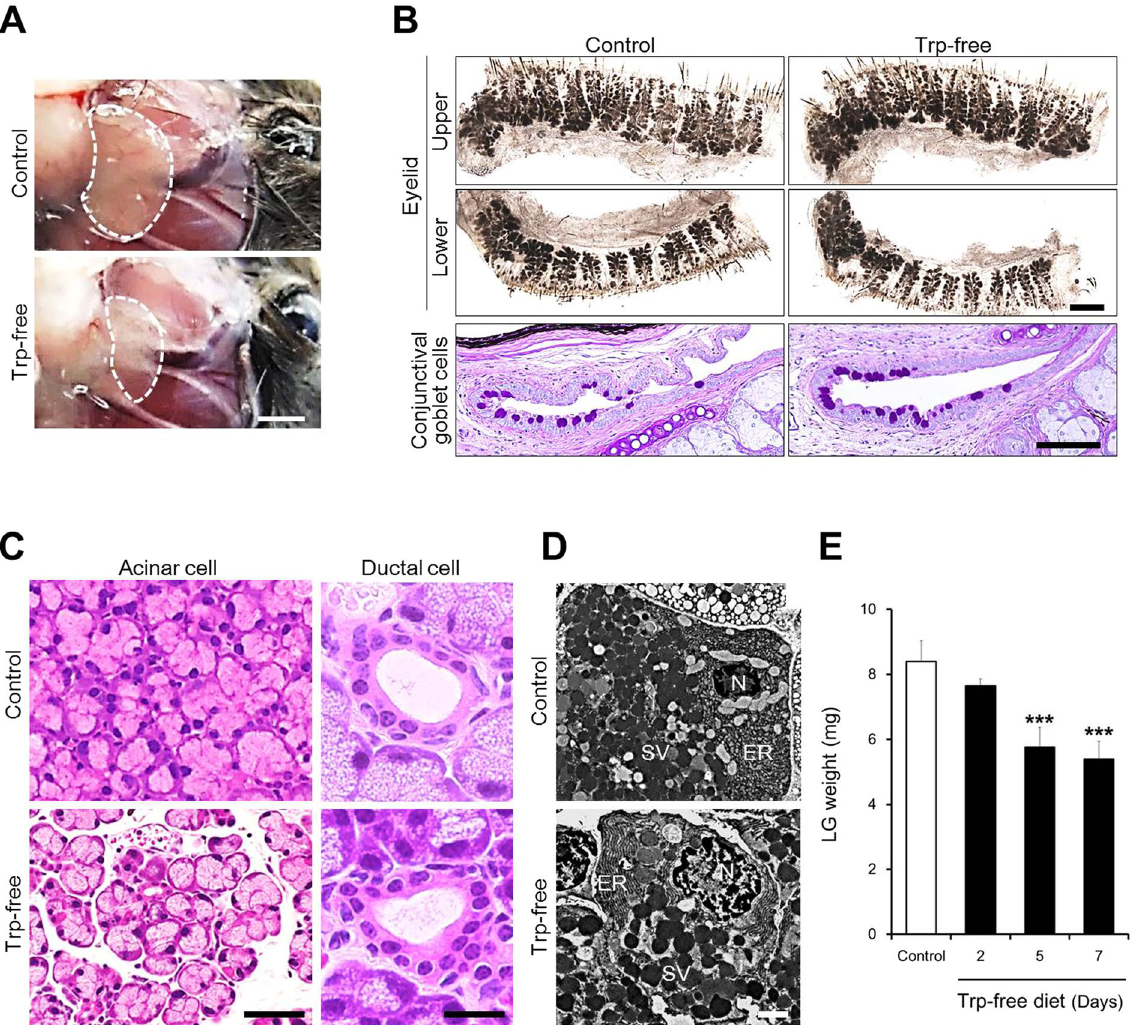
Figure 2. Decrease in blood 5-HT concentration induces lacrimal gland atrophy. ( A ) Effect of Trp-free diet on the LG (upper: control, lower Trp-free diet group). The dotted line indicates LG (scale bar: 2 mm). ( B ) Effect of Trp-free diet on MG morphology and conjunctival goblet cell distribution. MG morphology was assessed by whole-mount eyelid meibography (scale bar: 100 µ m). Conjunctival goblet cells were stained by PAS (scale bar: 100 µ m). Number of conjunctival goblet cells was 32 in the control and 36 in the Trp-free group. Each panel shows the control group (left) and Trp-free diet group (right). ( C ) Histopathological changes in LG acinar cells and ductal cells. Scale bar is 50 µ m (acinar cells) and 10 µ m (ductal cells). ( D ) Typical transmission electron microscopy (TEM) images of LG acinar cells (scale bar: 1 µ m). The nucleus, secretory vesicles, and endoplasmic reticulum are shown as N, SV, and ER, respectively. Each panel (C,D) shows the control group (upper) and Trp-free group (lower). Photographs show at day 7 after changing to a Trp-free diet ( A – D ). ( E ) Changes in LG weight during the 7 days of Trp-free diet feeding. All data represent the mean ± SD, n = 5 LGs. *** P < 0.001 versus control ( E